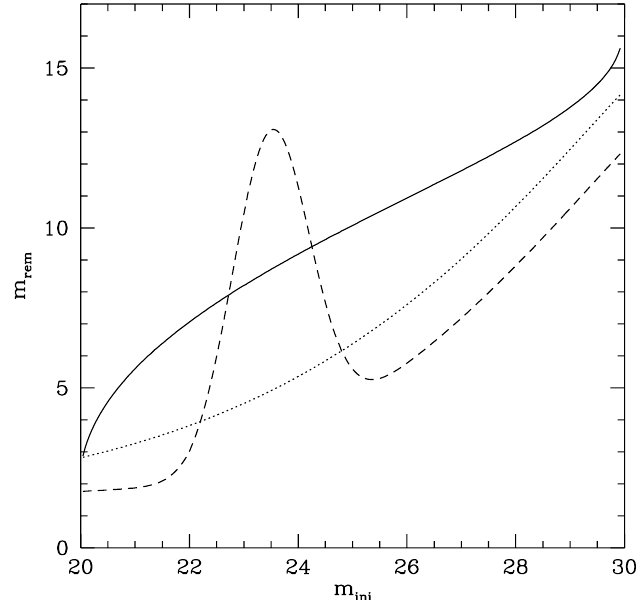
Fig. 2. Remnant mass versus initial stellar mass relation. The solid curve is the result of this study, Equation (7). The other relations are taken from Fryer et al. (2012) for fast-convection (dashed curve) and delayed-convection (dotted curve)